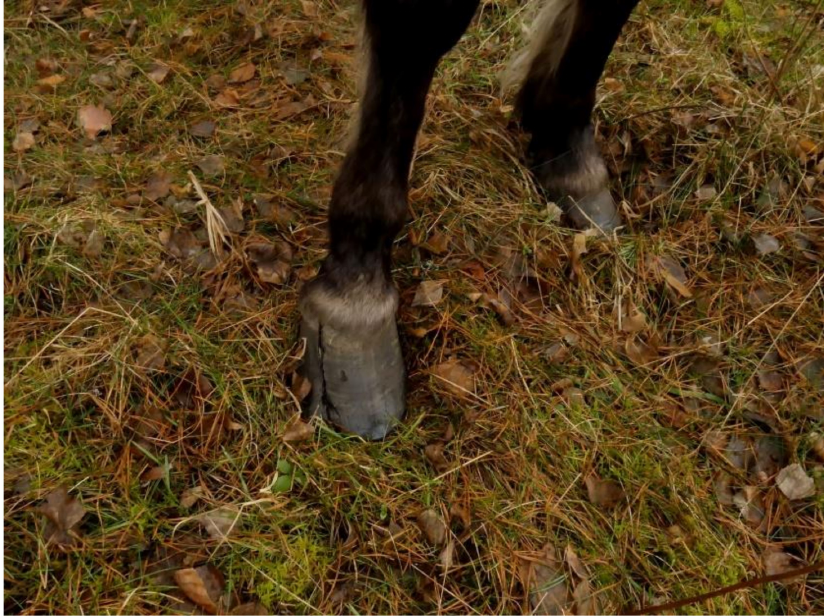
Figure 3. Cracked hoof in a Konik mare (photo by Marta